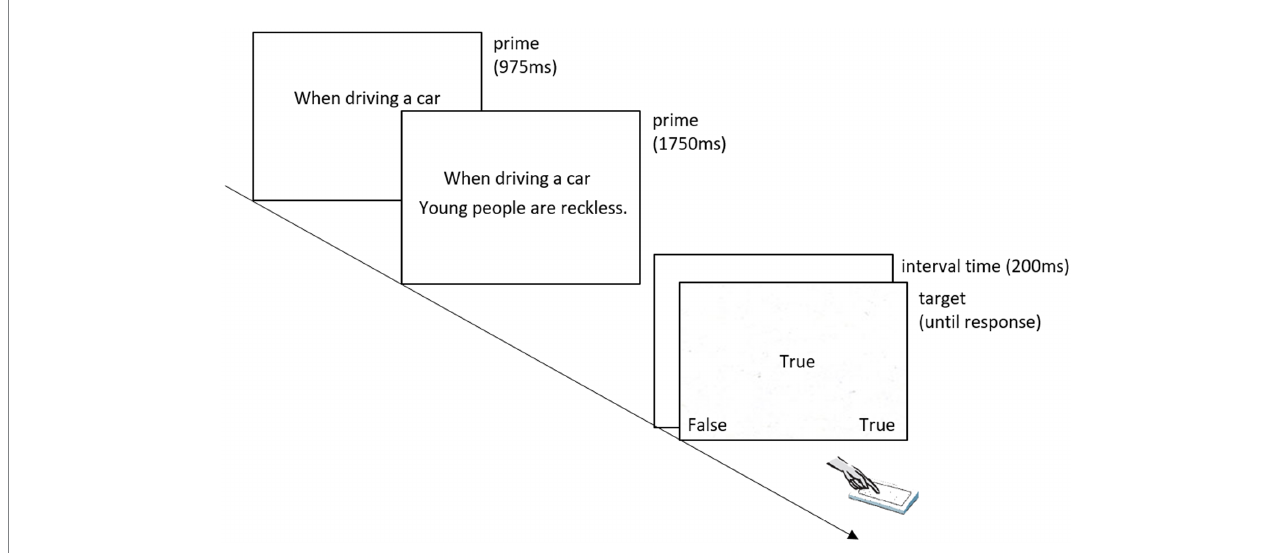
FIGURE 1 Presentation of an individual item in a PEP trial. Note that presentation time accounts for differences in word